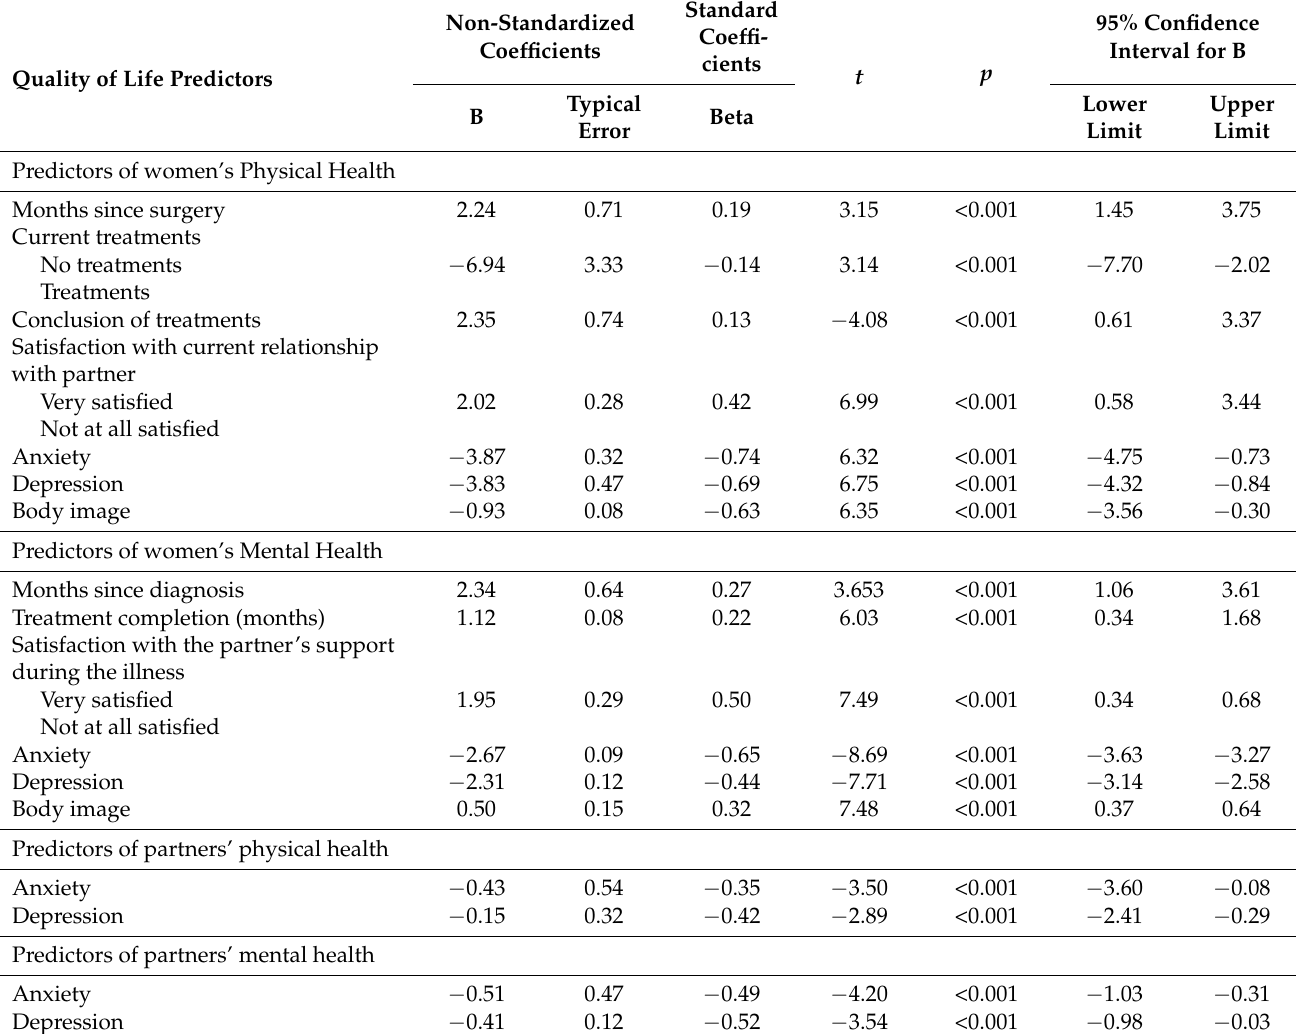
Table 2. Predictors of quality of